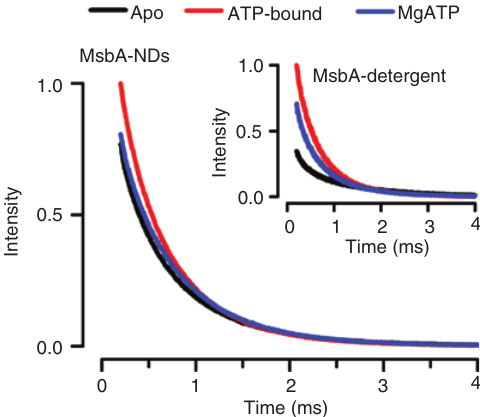
Figure 5: Comparison of MsbA in nanodiscs with MsbA in